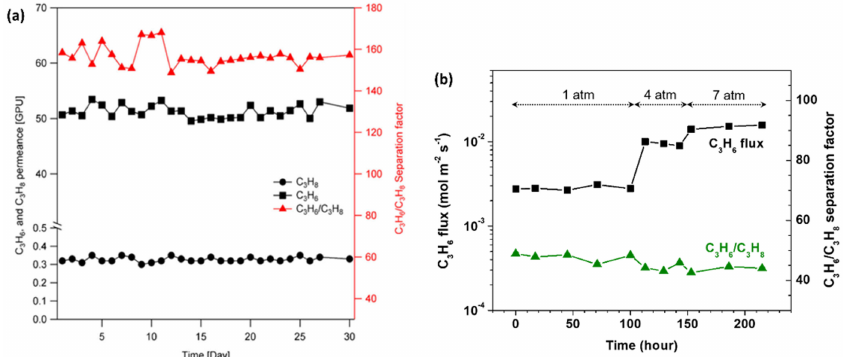
Figure 11. On-stream stability of C 3 H 6 /C 3 H 8 mixture separation performance. ( a ) Stability of a ZIF-8 hollow fiber membrane operated continuously for 30 days under an equimolar C 3 H 6 /C 3 H 8 mixture feed at 25 ◦ C and 1 bar feed pressure [94]. ( b ) Stability of a ZIF-8 membrane made by LIPS method tested at room temperature with an equimolar C 3 H 6 /C 3 H 8 mixture feed under different